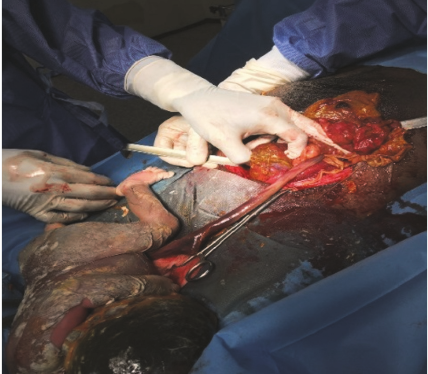
Figure 2: Uterus about 14